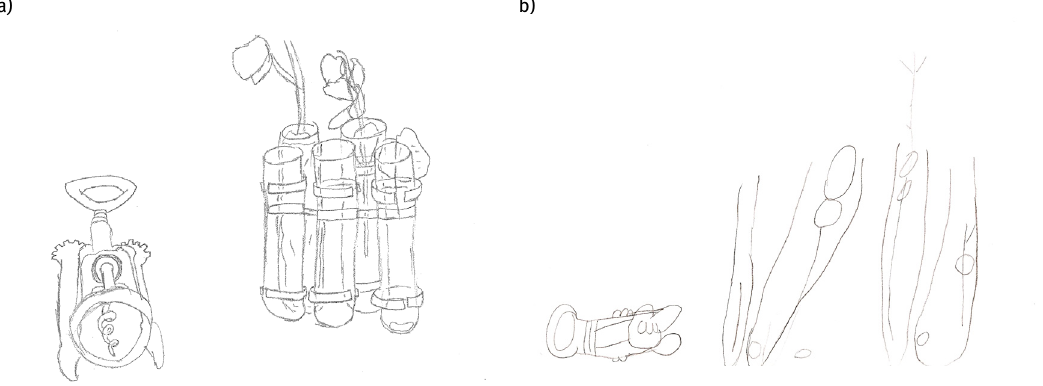
Figure 2. Vase with flowers and corkscrew drawn by a child with precocious realism (A) and a child without a gift at realistic depiction (B), both at ten years old, with photograph of the vase and corkscrew (after Drake et al., 2010, figure 4, with kind permission). Pencil drawings shown at higher contrast for clarity.